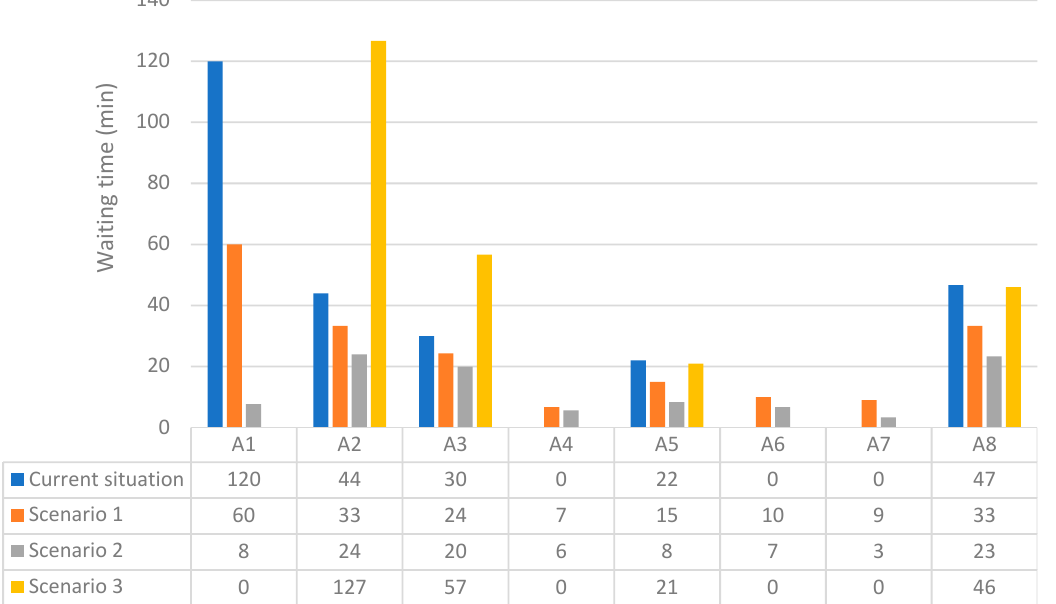
Figure 11. Comparison of scenarios simulation results with the current waiting times.